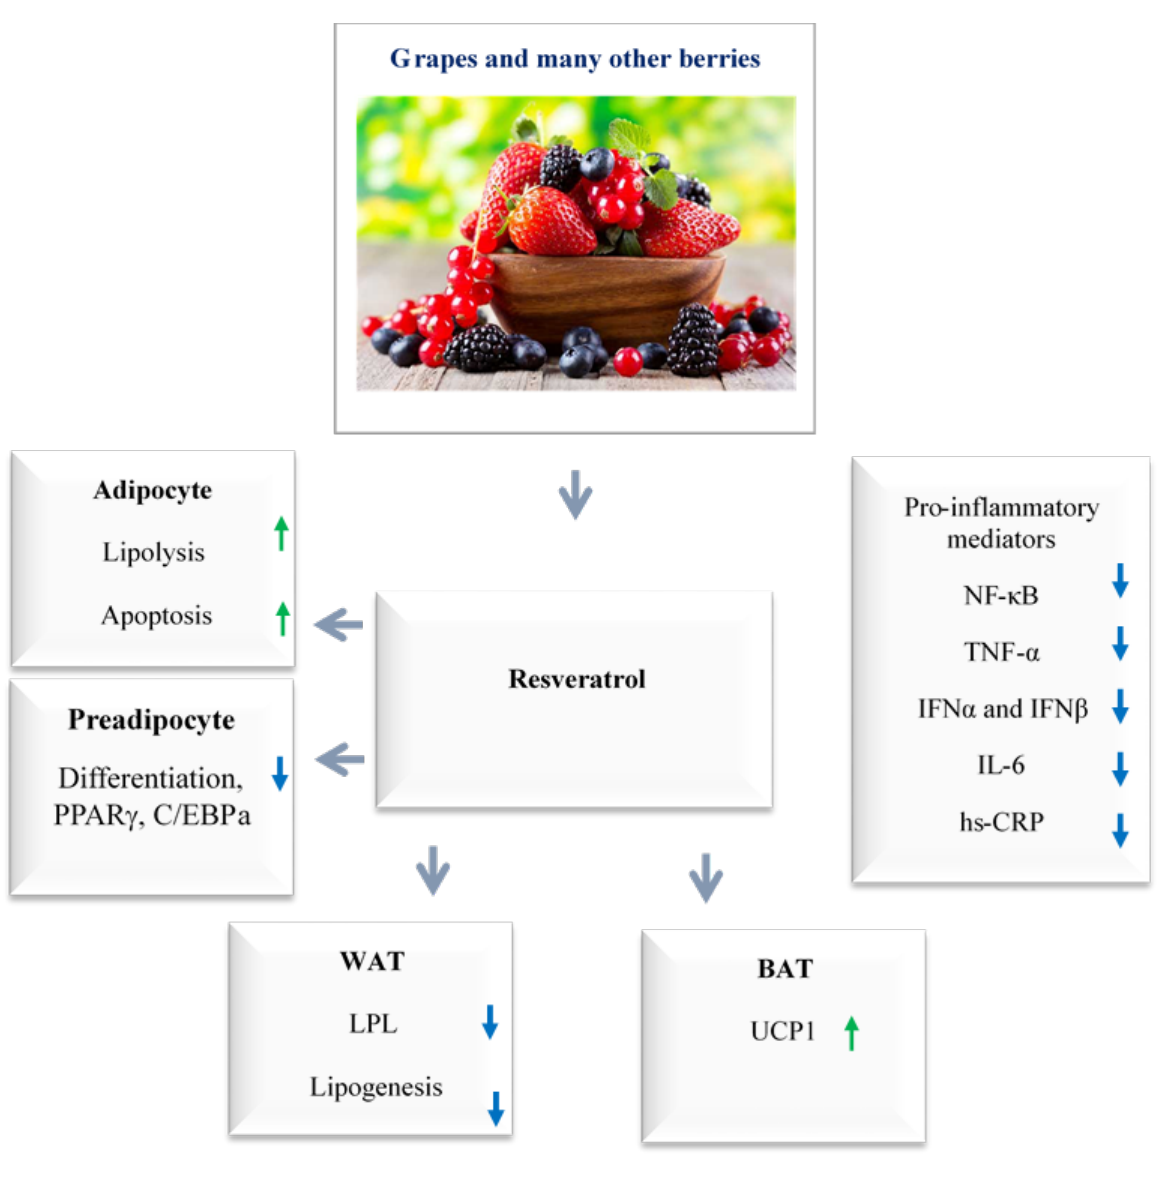
Figure 4. Action mechanisms of anti-obesity effects of resveratrol. BAT: brown adipose tissue; C/EBP: CCAAT/enhancer-binding protein; LPL: lipoprotein lipase; PPAR: peroxisome proliferator- activated receptor; UCP: uncoupling protein; WAT: white adipose tissue. NF- κB: nuclear factor - κB; TNF- α: tumor necrosis factor- α; IL -6: interleukin-6; IFN: interferon; hs-CRP: high sensitivity C-reactive protein.